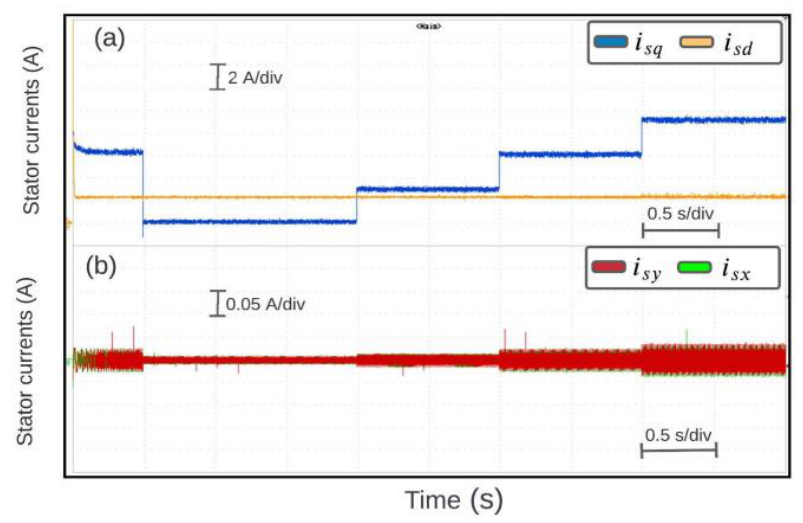
Figure 7. OeW-5PIM performance under load torque variations ( a ) stator currents in d-q frames; ( b ) stator currents in x-y frames. Figure 8. The stator currents in α-β frames.